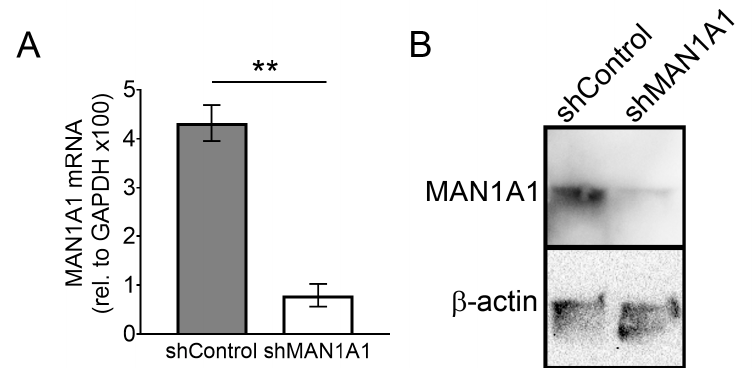
Figure A1. Inhibition of MAN1A1 with shRNA. ( A ) RT-PCR showing reduction of mRNA levels ( n = 4). ( B ) Western blot showing reduction of protein levels ( n = 2). ** p < 0.005.